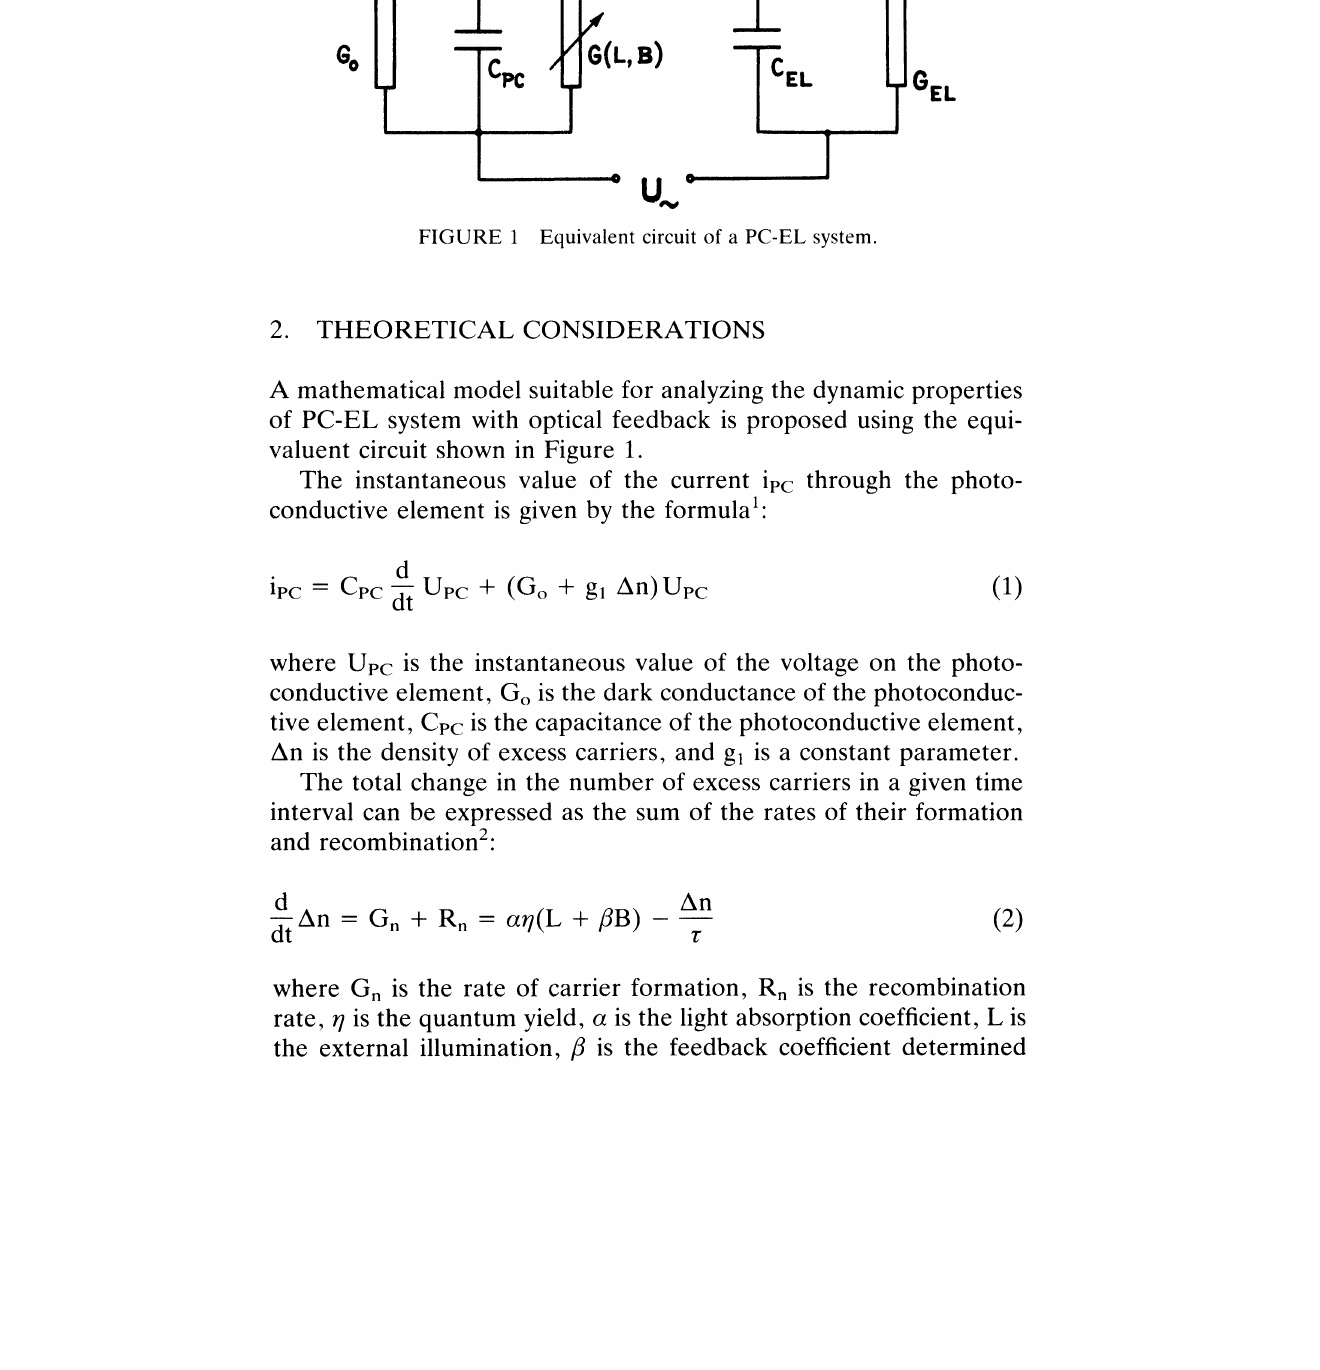
FIGURE Equivalent circuit of a PC-EL system.